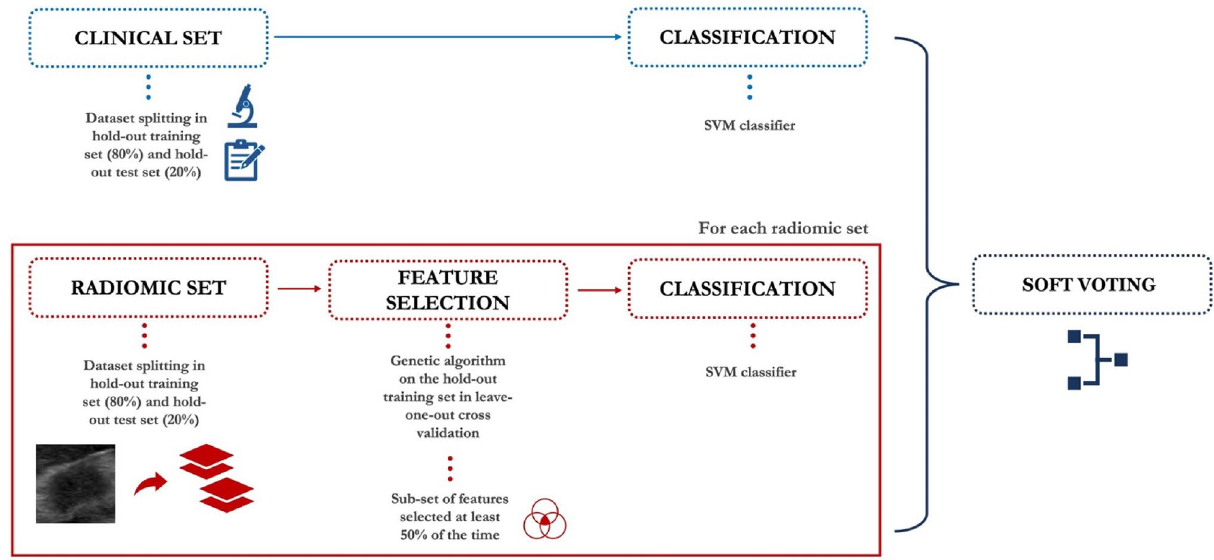
Figure 4. Schematic overview of the proposed approach. First, clinical and radiomic features were evaluated separately by implementing two different machine learning approaches. Subsequently, a soft voting technique was performed between the clinical-based model and each radiomic-based